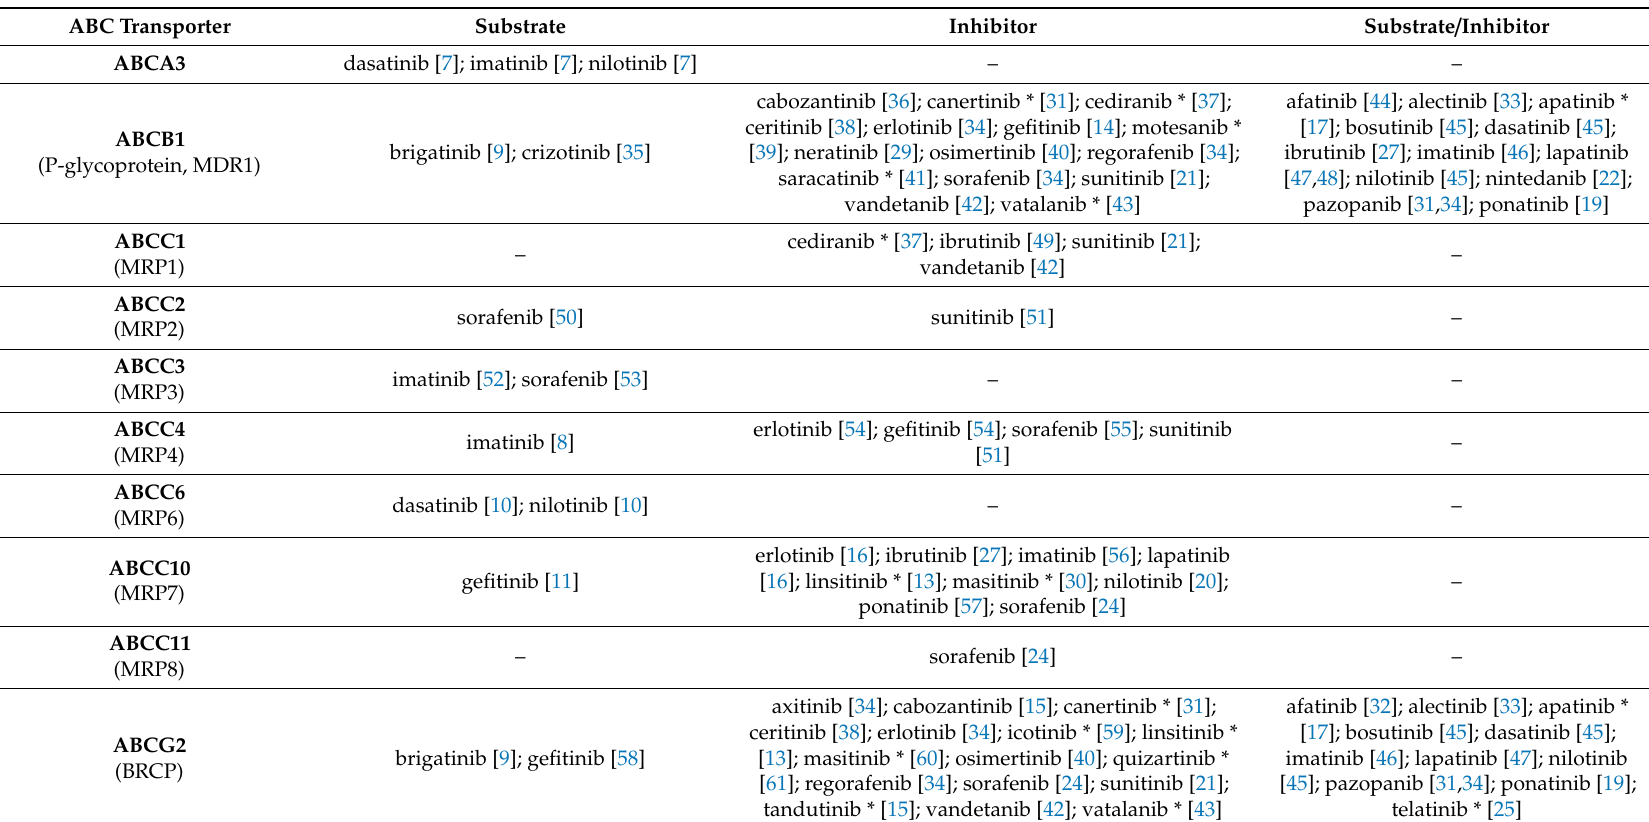
Table 1. Interactions of selected TKIs with ABC